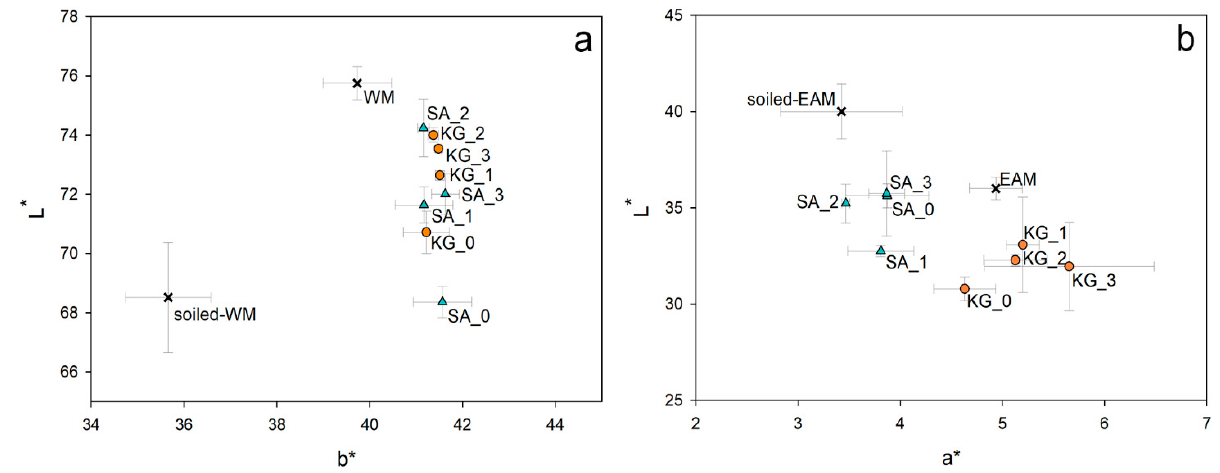
Figure 6. Scatter plots showing ( a ) L * and b * values measured on WM, soiled-WM, and areas repeatedly cleaned with SA and KG gels and ( b ) L * and a * values measured on EAM, soiled-EAM, and areas repeatedly cleaned with SA and KG gels.